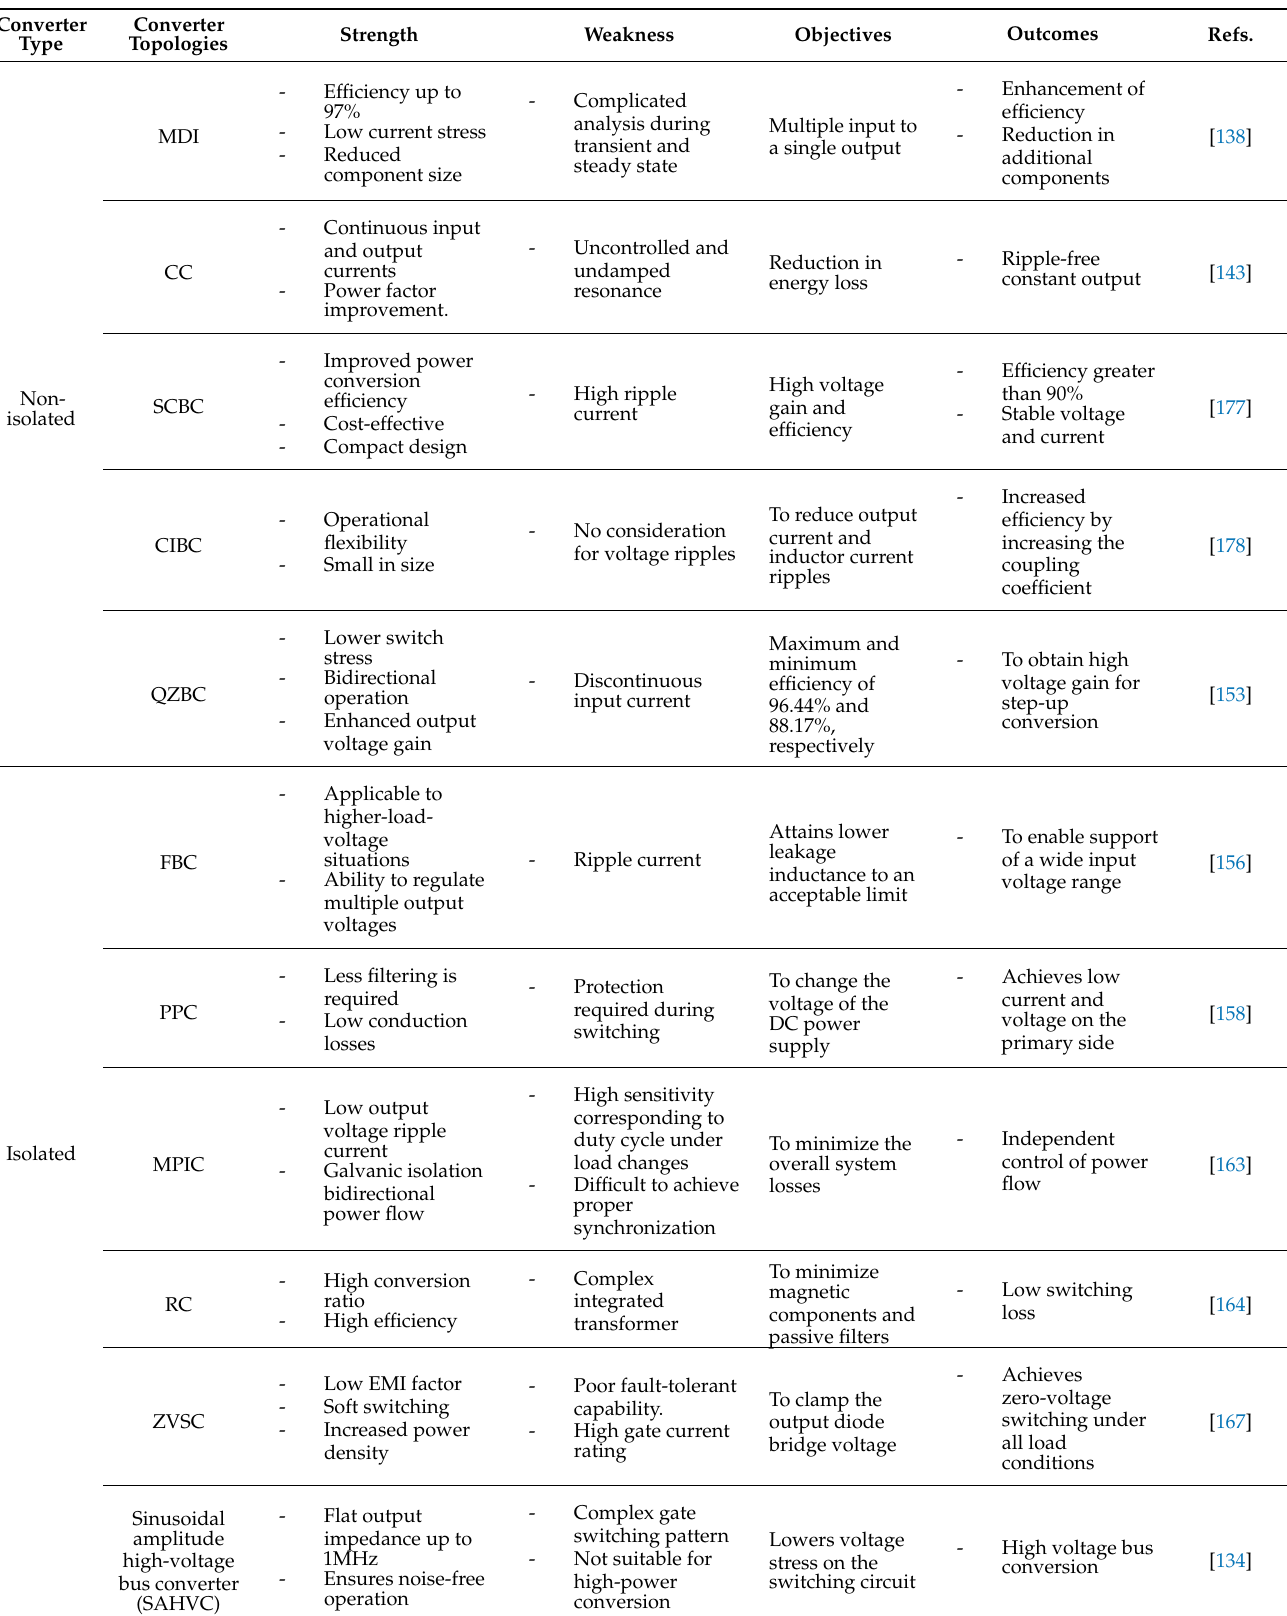
Table 2. Comparison of various power electronic converters in EV